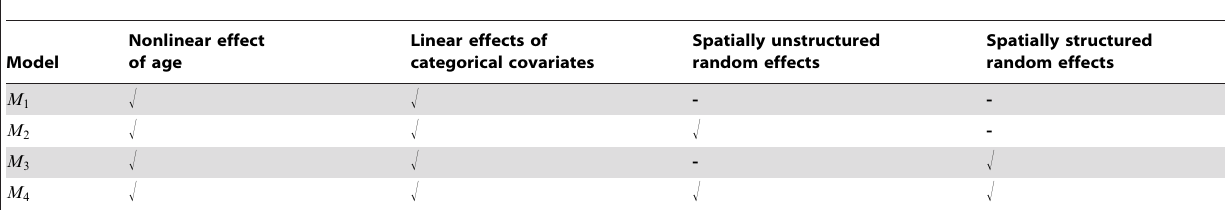
Table 2. Nesting nature of the models under study.